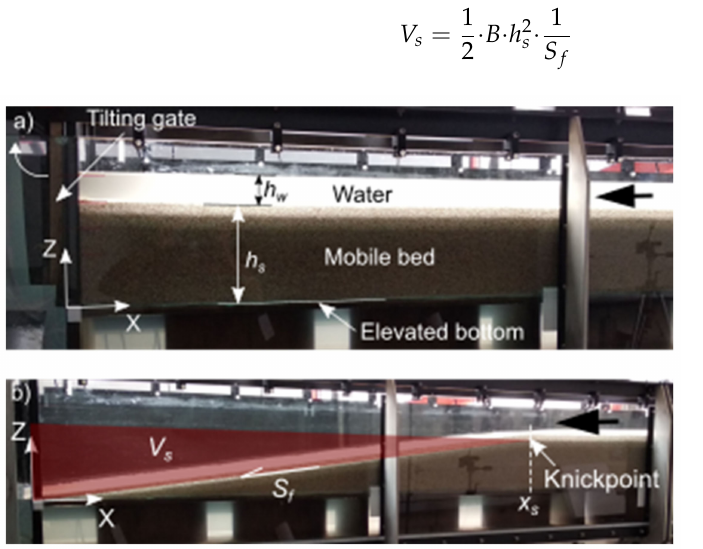
Figure 2. ( a ) Lateral view of the experimental facility just before the beginning of one experiment. ( b ) Lateral view of the experimental facility at the end of the